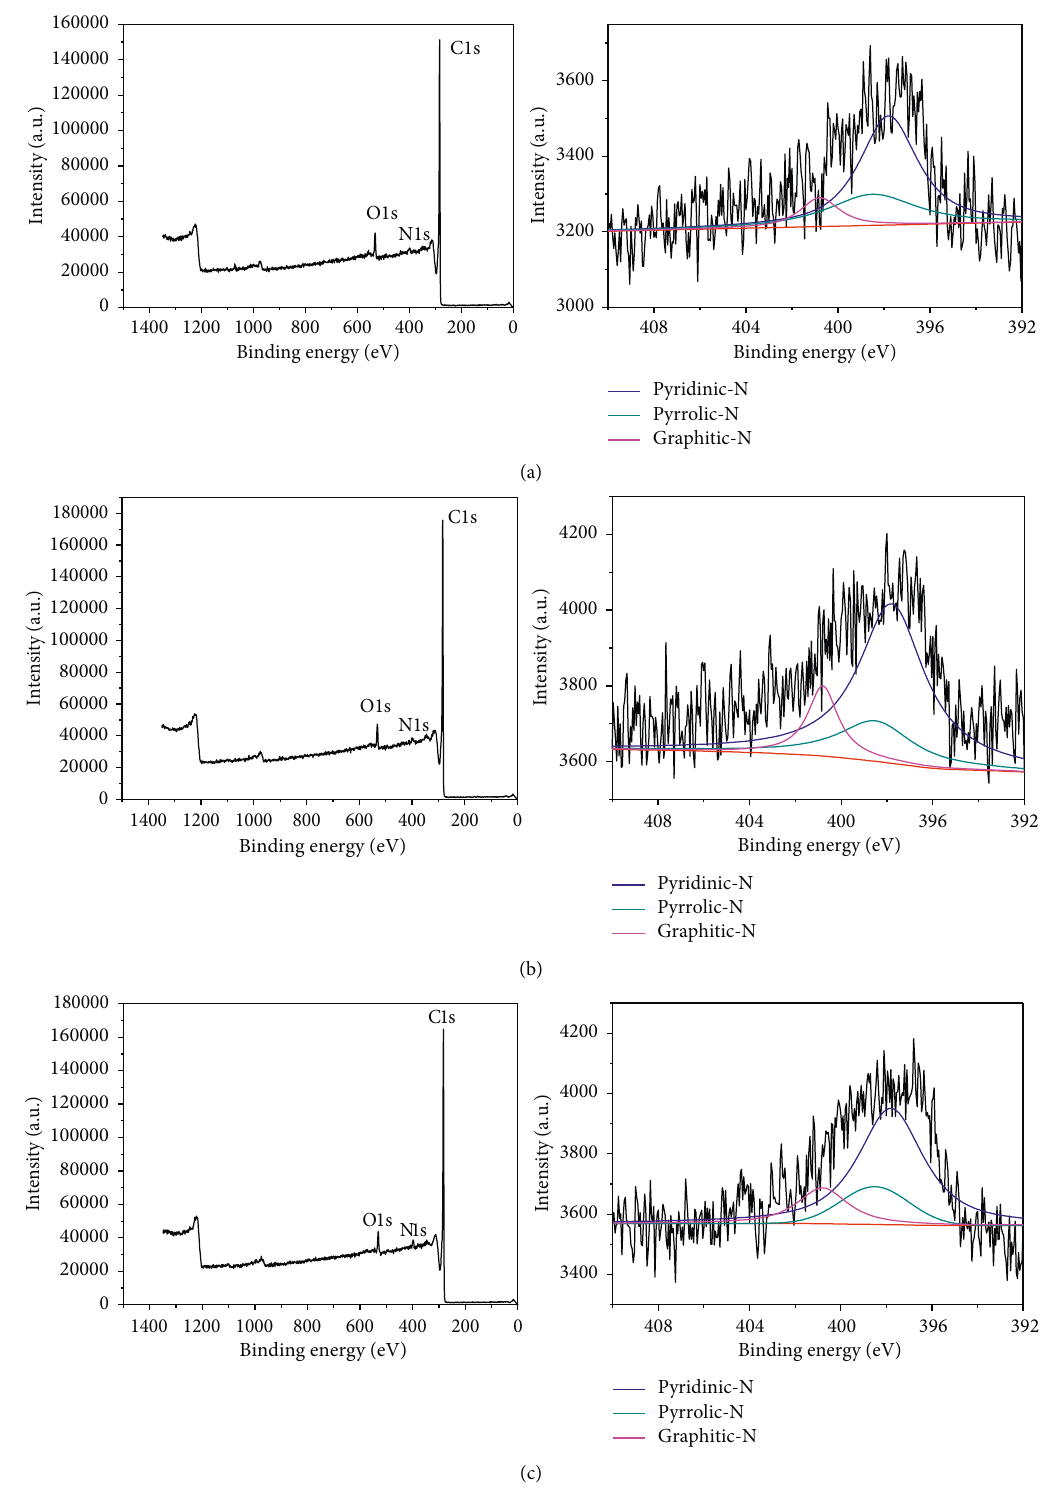
Figure 5: XPS spectra and curve fit of N1s spectra from the prepared N-rGO-500/GF (a), N-rGO-700/GF (b), and N-rGO-900/GF that the disorder of GF electrode increases after modifica- Figure 6. By comparing the value of I / I before and after D G tion. This may ascribe to the introduction of defects and the electrode surface modification, no significant difference is remarkable decrease of the size of the in-plane sp 2 domains found. However, the D band and the G band of the N-rGO- 500/GF are broader than that of the pristine GF, suggesting by nitrogen doping [33].